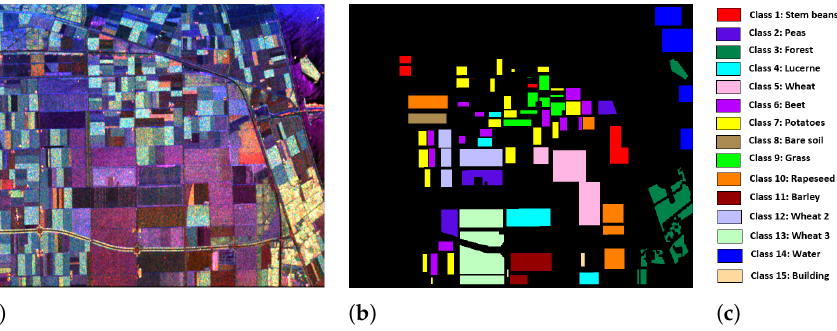
Figure 3. The Flevoland dataset. ( a ) Pauli RGB image; ( b ) ground truth; ( c ) color code of the different